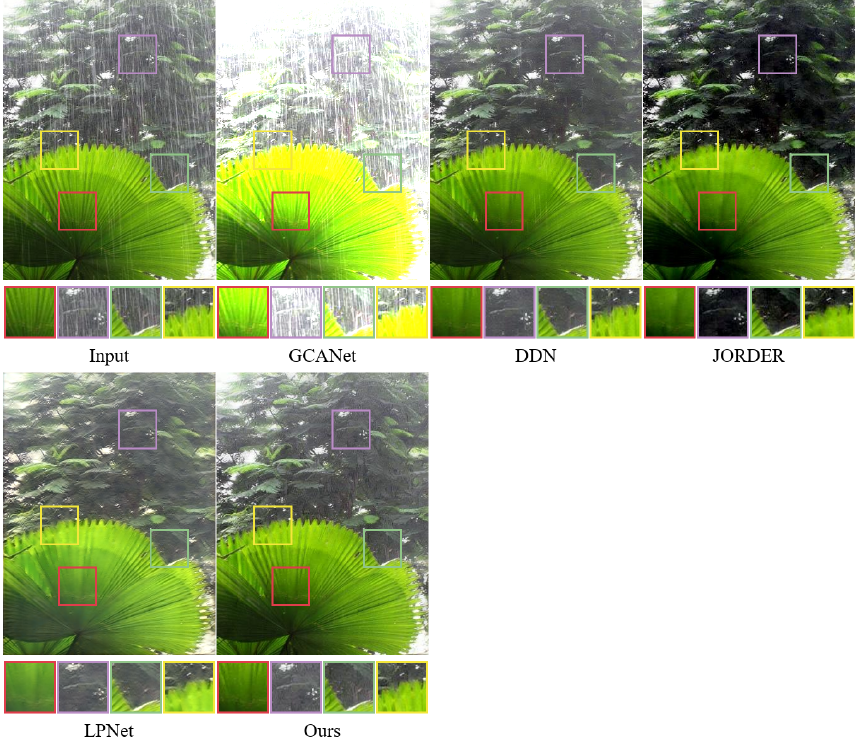
Figure 8. The performance of different methods on real world rainy dataset (Scene